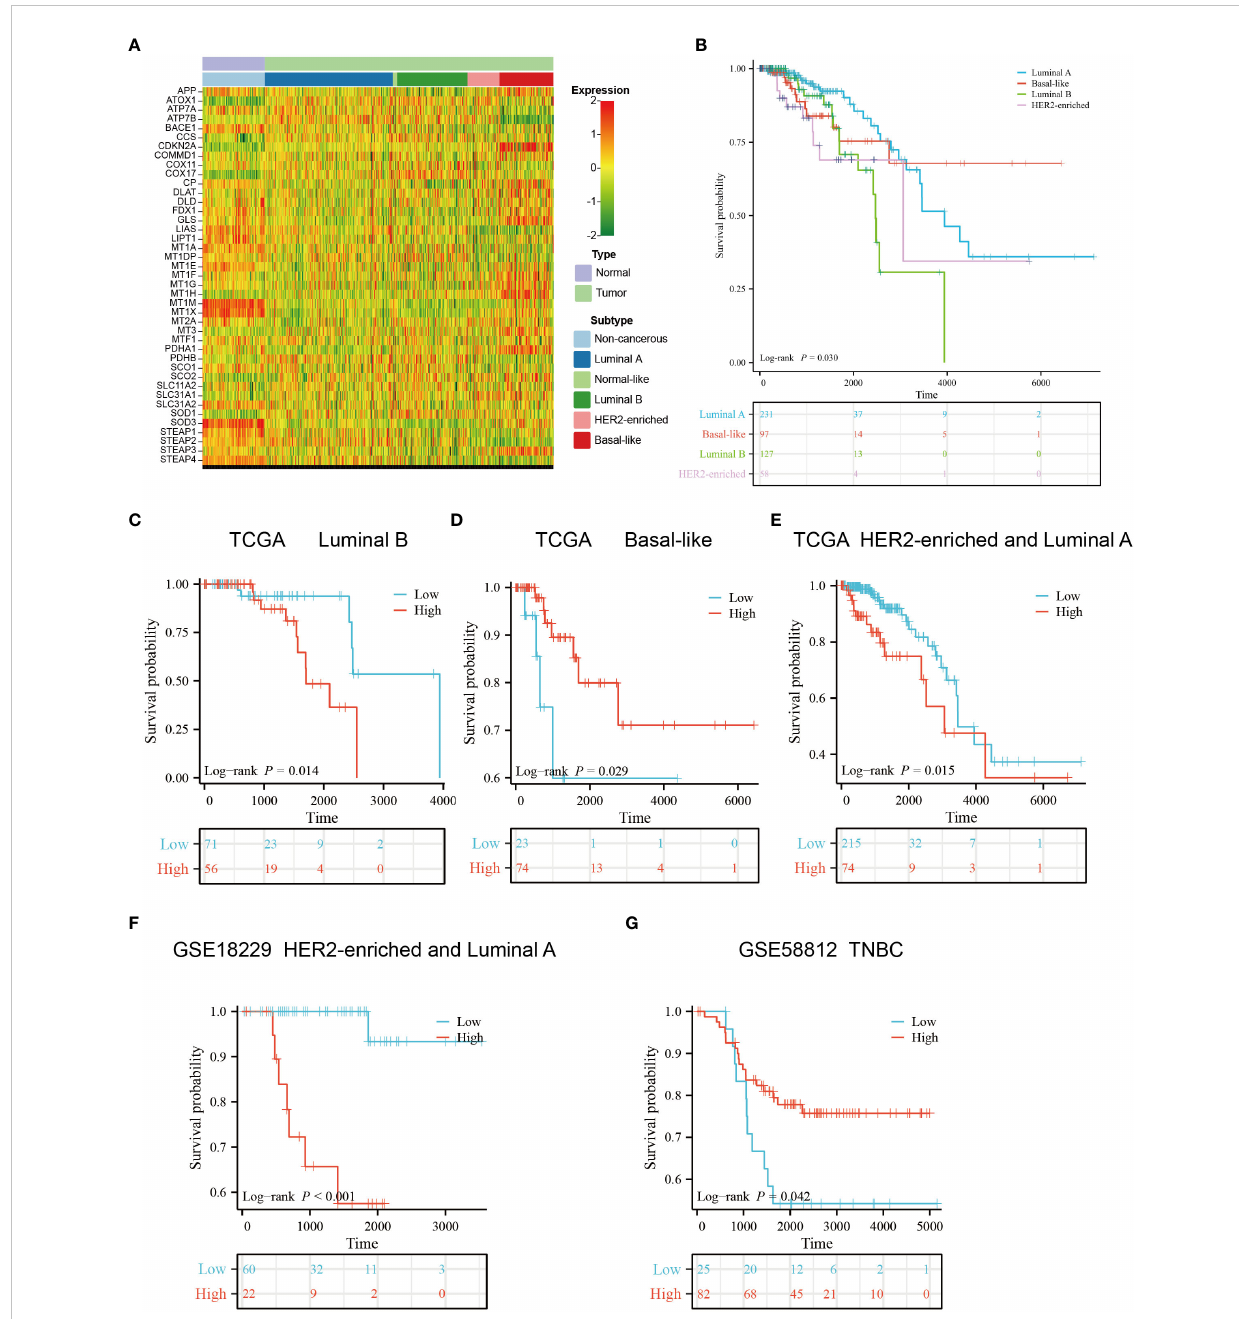
FIGURE 10 Gene expression pro fi le and survival analysis of different subtypes of breast cancer strati fi ed by the risk score of copper-related genes. (A) The gene expression heatmap of different subtypes of breast cancer. The subtype information was obtained from Xena. (B) The Kaplan – Meier curves of luminal A, luminal B, HER2-enriched and basal-like breast cancer patients. The Kaplan – Meier curves of luminal B (C) , basal-like (D) , luminal A and HER2-enriched patients (E) from TCGA. (F) The Kaplan – Meier curves of luminal A and HER2-enriched patients from GSE18229. (G) The Kaplan – Meier curves of Triple-negative breast cancers (TNBC) patients from GSE58812. The group was strati fi ed based on the risk score of copper-related genes at the best cut-off